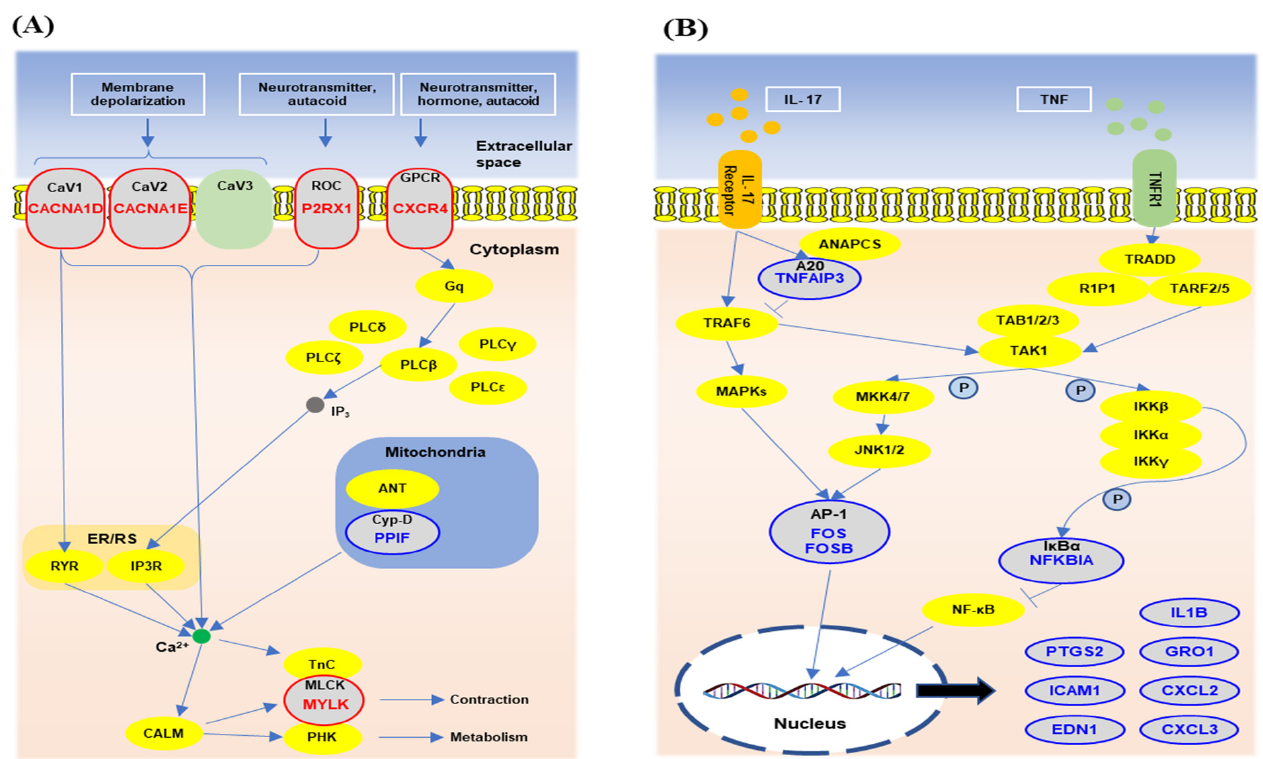
Figure 4. Top-ranked and interested pathways in Holstein and Jersey cows. Among the top five ranked KEGG pathways, the predominant pathway in Holstein and Jersey PBMCs is shown. The calcium signaling pathway of Holstein cows ( A ) and the IL-17 and TNF signaling pathways of Jersey cows ( B ) are presented with identified pathway associated genes. Blue and red colors indicate down-regulation and up-regulation, respectively.